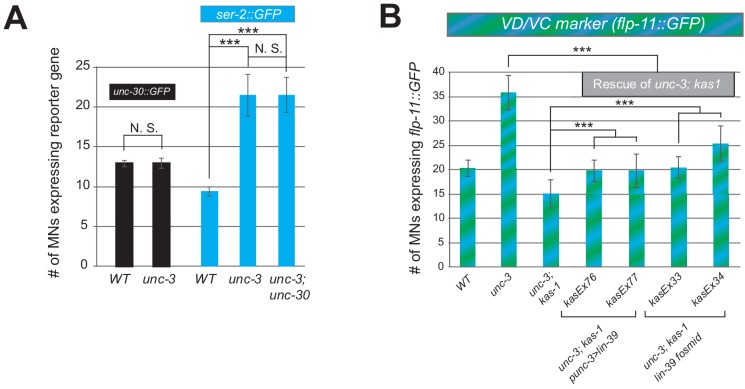
Ectopic expression of VD terminal identity markers in unc-3 mutants requires LIN-39 but not UNC-30.(A) Quantification of unc-30::gfp and VD marker ser-2::gfp in WT and unc-3 (n3435) animals at L4, with ser-2::gfp further examined in unc-3 (n3435); unc-30 (e191) double mutants. Expression of ser-2::gfp is equally affected in unc-3 (n3435) single and unc-3 (n3435); unc-30 (e191) double mutants. N > 15. ***p<0.001. N. S: not significant. (B) Quantification of the VD/VC marker flp-11::gfp expression in L4 stage WT, unc-3 (n3435) mutant, unc-3 (n3435); kas1, and transgenic animals that rescue unc-3 (n3435); kas1 background with expression of lin-39 in cholinergic MNs (Punc-3 >lin-39) or expression of GFP-tagged lin-39 fosmid. Two independent transgenic lines were used for Punc-3 >lin-39 OE and lin-39 fosmid. Of note, the partial rescue observed with the Punc-3 >lin-39 OE lines likely arises because the fragment of unc-3 promoter used to drive lin-39 is not expressed in all 39 cholinergic MNs.